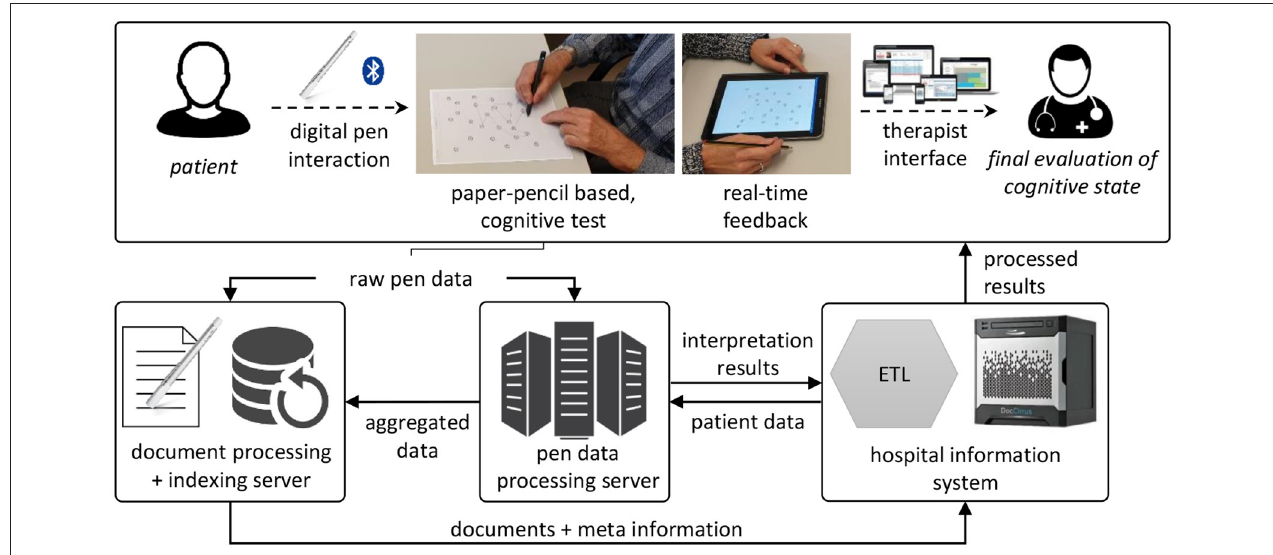
FIGURE 3 | Architecture of the interactive cognitive assessment tool. Data is recorded using a digital pen and streamed to a backend service, where it is analyzed before being loaded into the hospital information system and presented to the physician. ETL, extract, transform, load; a general concept of automatic data processing.